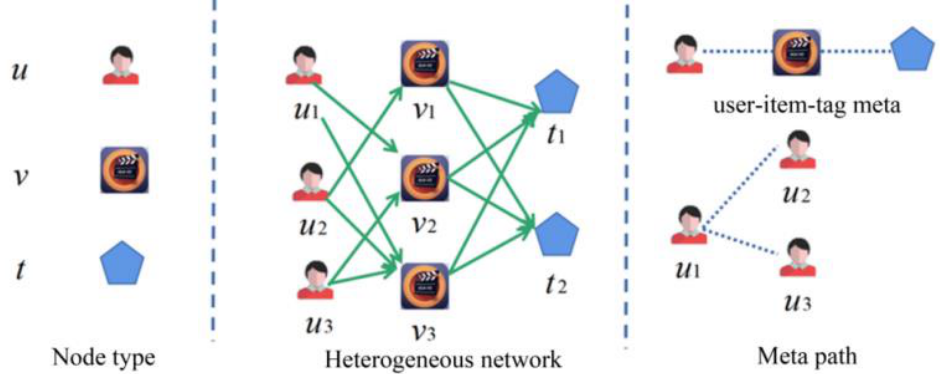
Figure 4. Diagram of heterogeneous network.